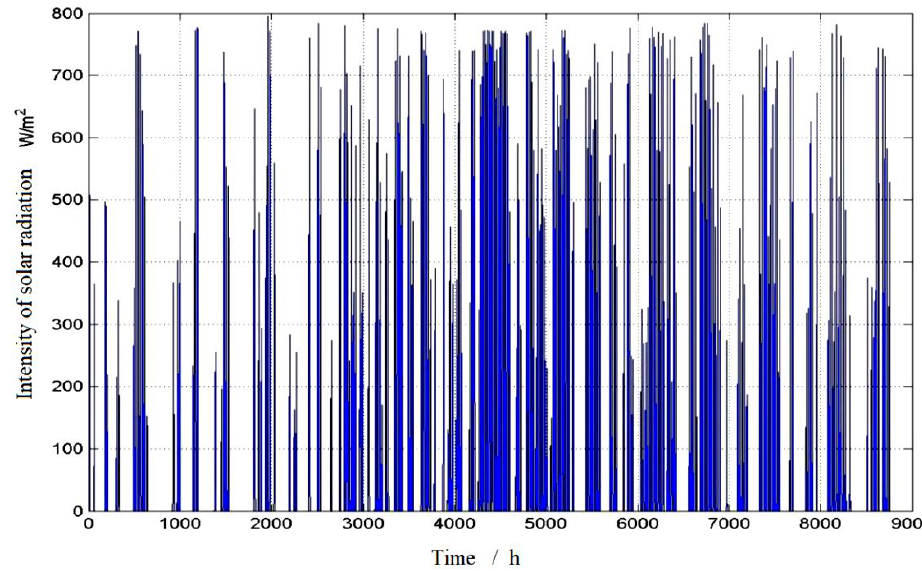
Figure 4. Annual hourly solar radiation intensity.